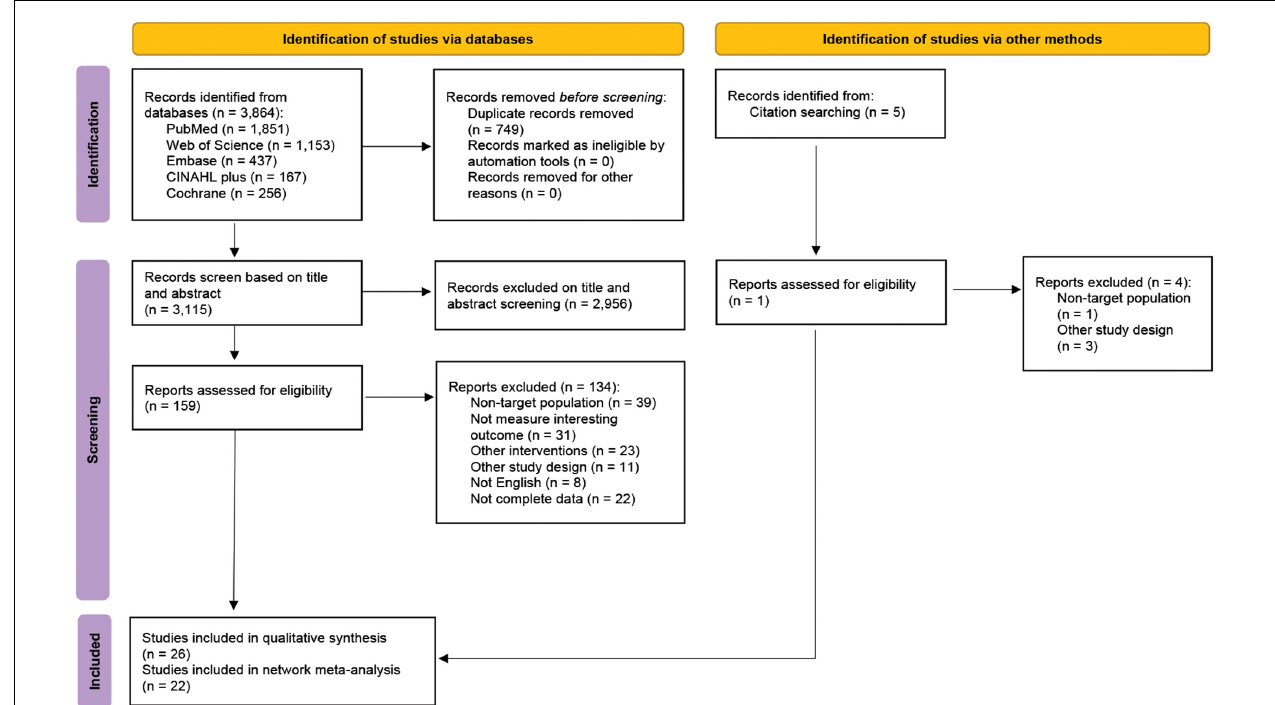
FIGURE 1 | Preferred reporting items for systematic review and meta-analyses (PRISMA) flow